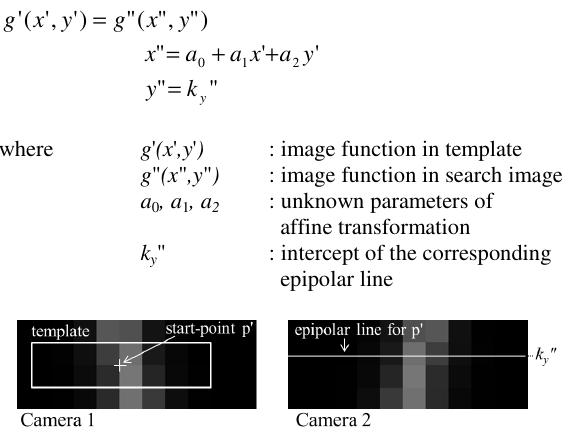
Figure 6. Principle of correspondence search for LSM